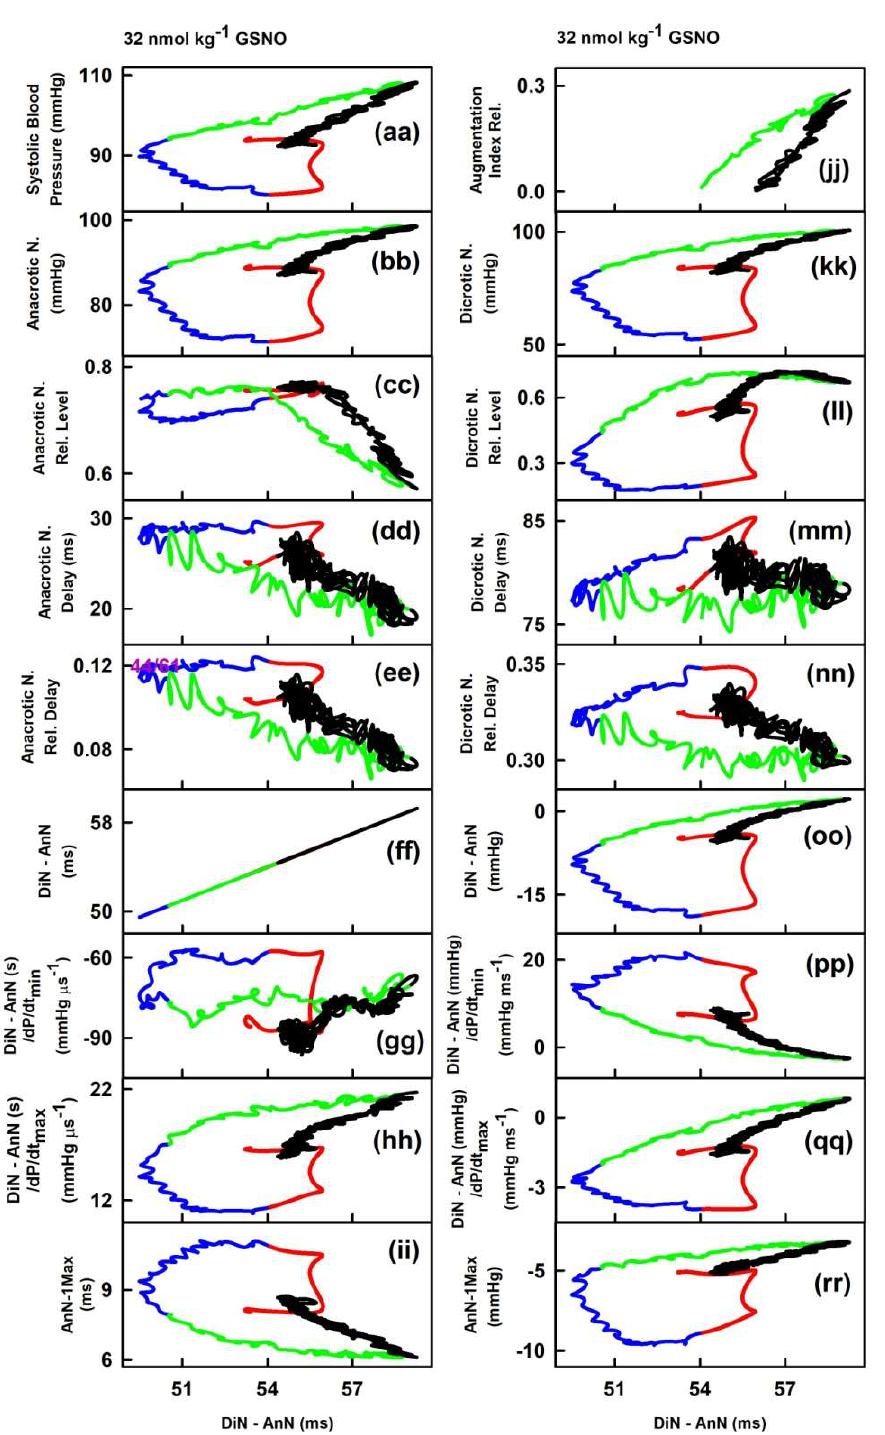
Figure 5. Relationships of HPs to the time interval between dicrotic (DiN) and anacrotic (AnN) notches after the administration of 32 nmol·kg –1 GSNO. The colors and time-dependent data correspond to Figure 2. Time period corresponding to the decrease of systolic BP (red), increase of systolic BP to the control value (blue), further increase of systolic BP to maximum (green), and decrease of systolic BP to the control value (black). The hysteresis was arbitrary defined as HPs-(DiN-AnN in ms) loop > 3 ms of DiN-AnN.